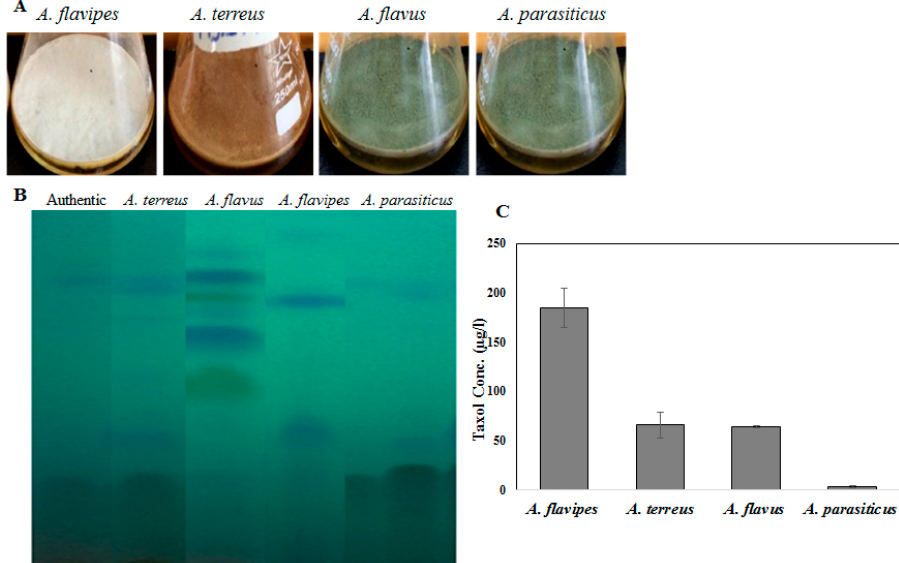
Figure 1. Taxol production by the selected fungal isolates: Aspergillus flavipes , A. terreus , A. flavus , A. parasiticus . ( A ) The morphological view of liquid cultures of Aspergillus flavipes , A. terreus , A. flavus , and A. parasiticus on PDB medium. ( B ) TLC chromatogram of the experimented fungal isolates. ( C ) Taxol concertation produced by the fungal isolates.